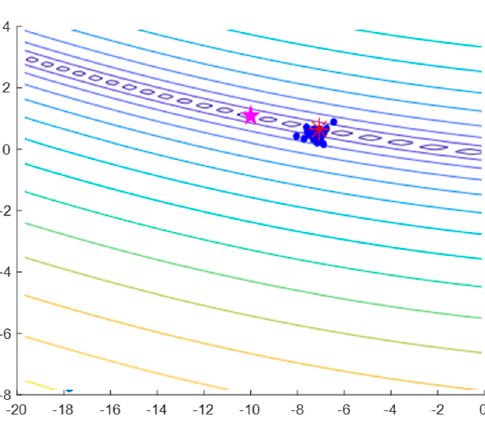
Figure 5. The random number distribution of the population after a few iterations.